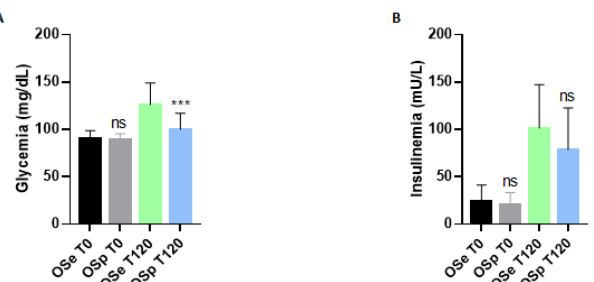
Figure 2. Determination of glycemia and insulin levels in sedentary obese children (OSe) compared to obese children who played sport (OSp). ( A ) Glycemia, ( B ) Insulin. Data are expressed as the means ± SDs. The significance was determined by the Student’s t -test: *** ( p -value < 0.001) and ns ( p > 0.05), not significative compared to sedentary obese children.